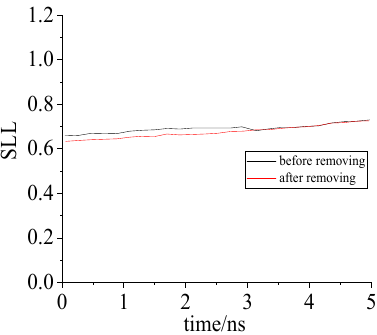
Figure 12. Comparison of before and after removing the unimportant elements.